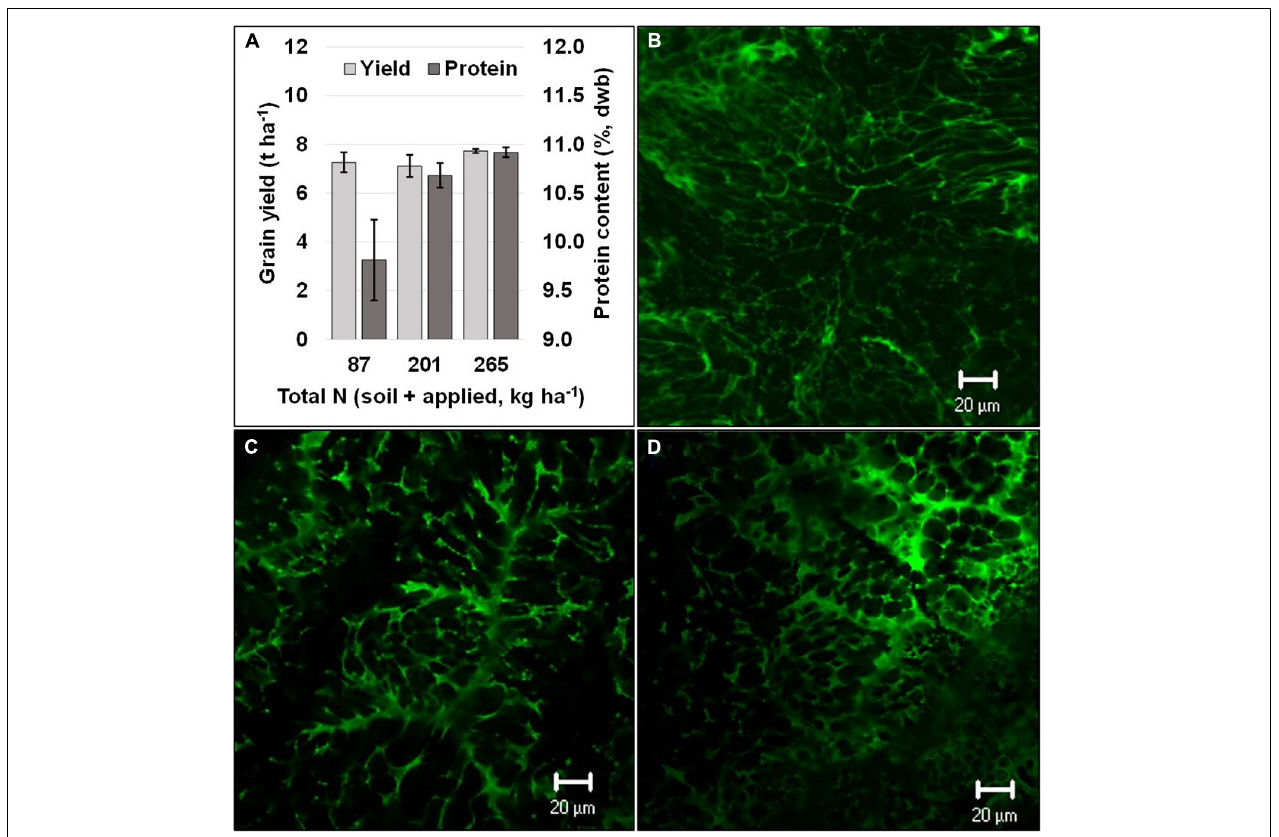
FIGURE 1 | Grain yield and protein (dry weight basis) at different N levels (A) and a visual comparison of confocal laser scanning micrographs of dried grain endosperm (green color obtained using fast green dye indicates protein) with differing grain protein content respective to the total N levels [ (B) 87 kg ha − 1 , (C) 201 kg ha − 1 , and (D) 265 kg ha − 1 ]. Black vertical bars overlaying the gray bars (A) represent standard error ( n =